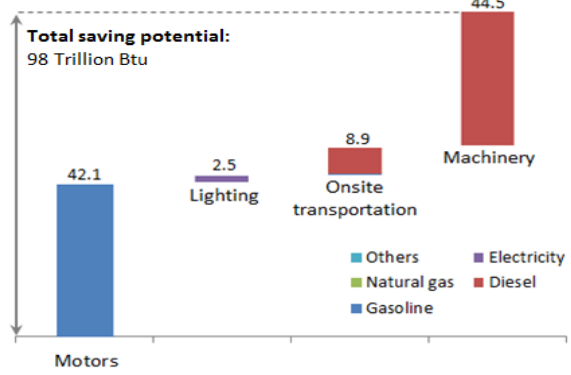
Figure 2. Energy saving potentials associated with US food sectors. Data source is [76].